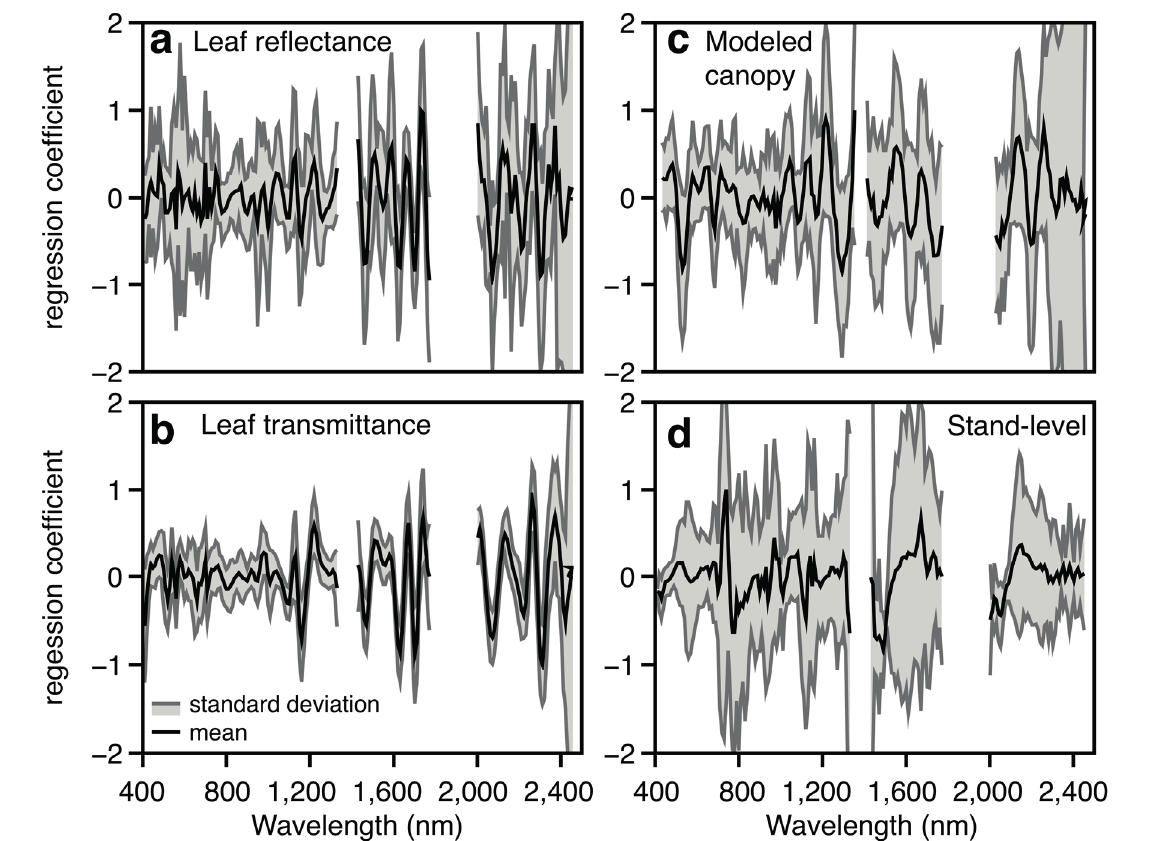
Figure 5. PLSR spectral weighting factors for NSC estimation in foliage at three scales: ( a ) leaf reflectance and ( b ) transmittance; ( c ) modeled canopy reflectance; and ( d ) actual forest stand-level reflectance. In each panel, the black line indicates the mean values, and the grey shading indicates one standard deviation among PLSR models run iteratively on random subsets of samples from each leaf, canopy and stand-level